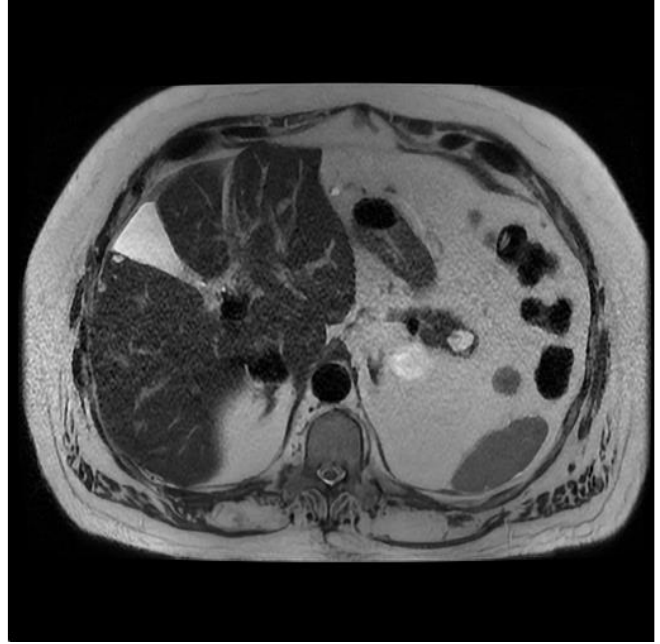
Figure 6. MRI of cNET of the pancreas.